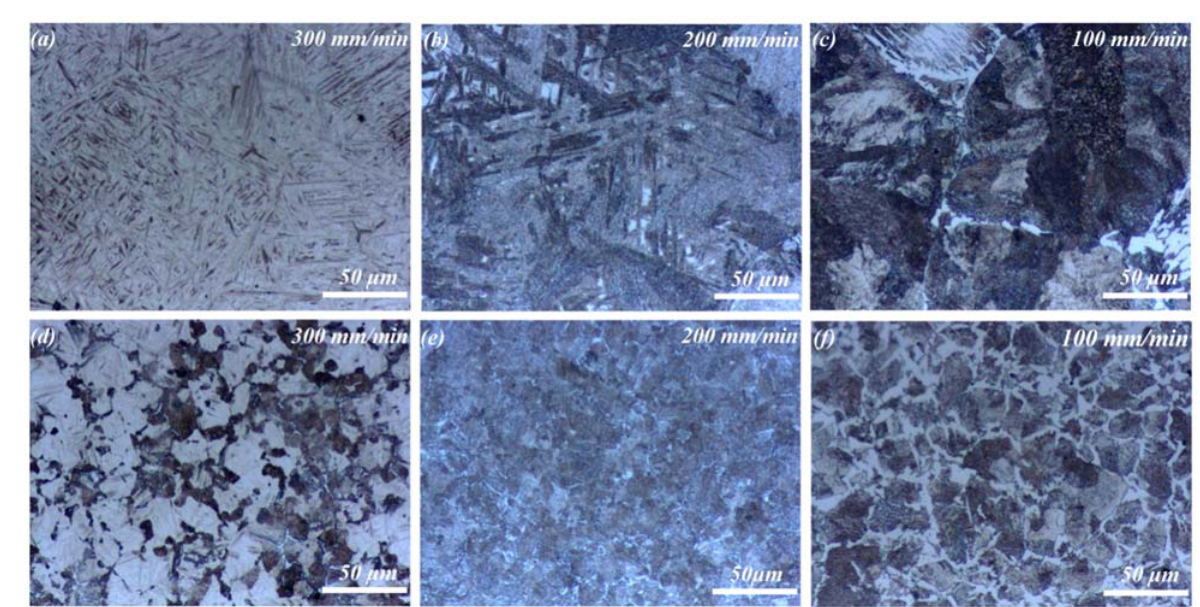
Figure 9. Optical morphologies of the HAZ at different scanning velocities, 5 kW: ( a – c ) upper region of the HAZ and ( d – f ) lower region of the HAZ.